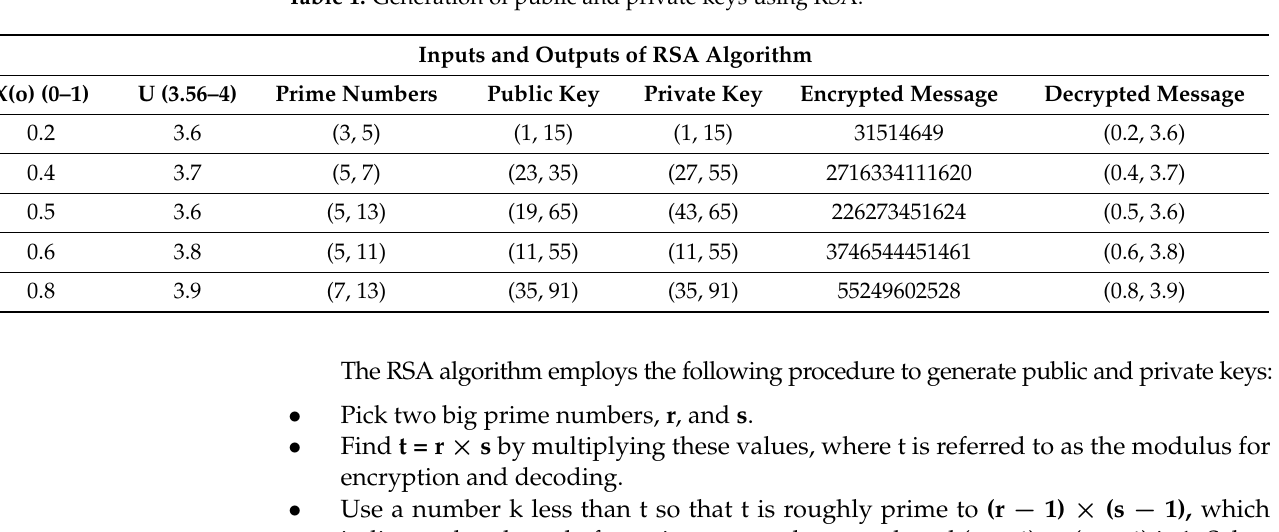
Figure 2. Three levels of DWT decompositions. 3.3. Singular Value Decomposition (SVD) SVD is a factorization of a given matrix with various applications in image processing [26]. The singular values (SVs) of an image have excellent soundness, i.e., (i) they will not change even after modifying the original image, and (ii) SVs address inborn arithmetical image properties. Here, an image can be addressed as a framework of positive scalar qual- ities.